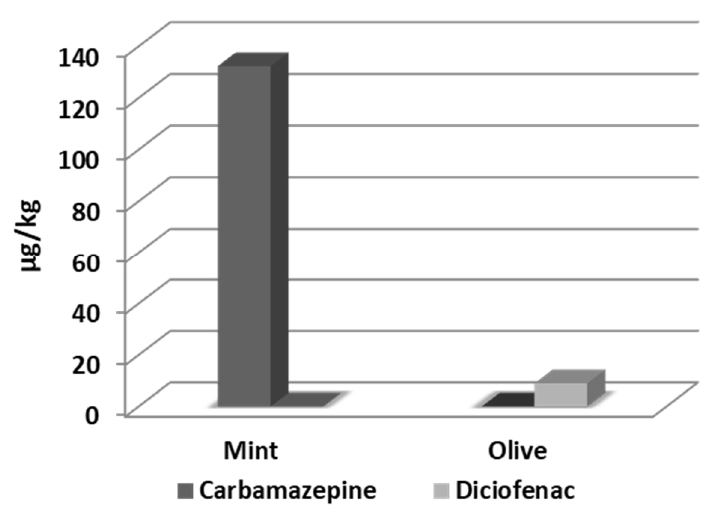
Figure 7. The concentration of carbamazepine and diclofenac uptake in mint leaves and olives irrigated with Fuhais-Mahis effluents.